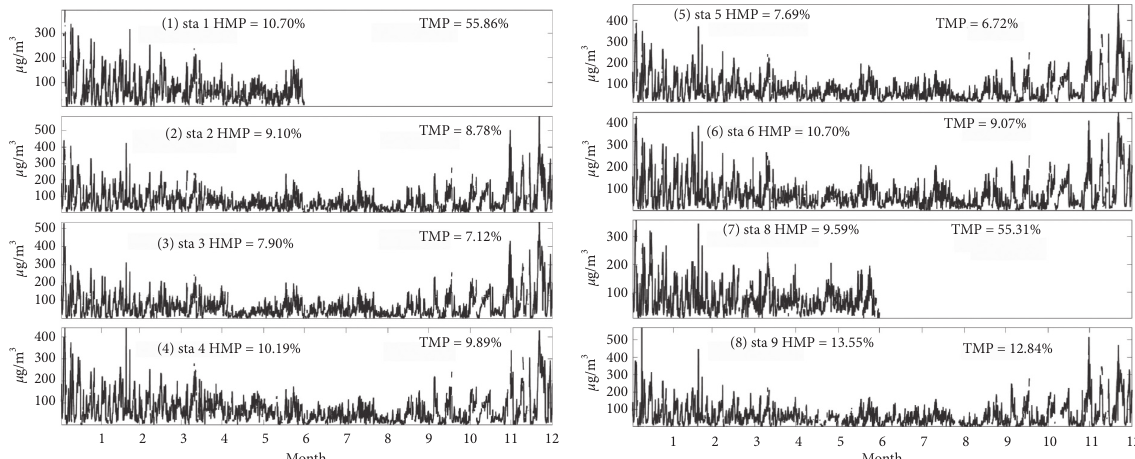
Figure 2: The original 12-month-long PM2.5 data records of 8 stations (sta 1, 2, 3, 4, 5, 6, 8, and 9) used in this study. The first half year missing percentage (HMP), i.e., the percentage of missing data in the first 4318 hours, and the total missing percentage (TMP), i.e., the percentage of missing data in 8735 hours, of each station are marked on the